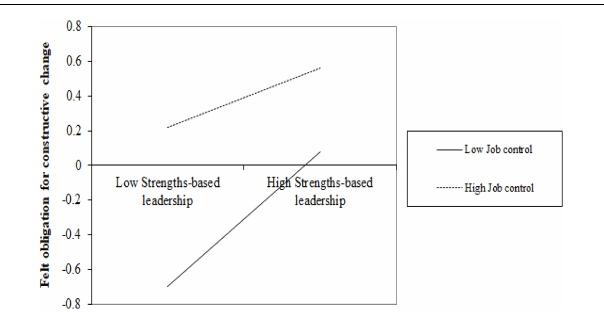
FIGURE 2 | Moderating effect of self-efficacy on the relationship between strengths use and job